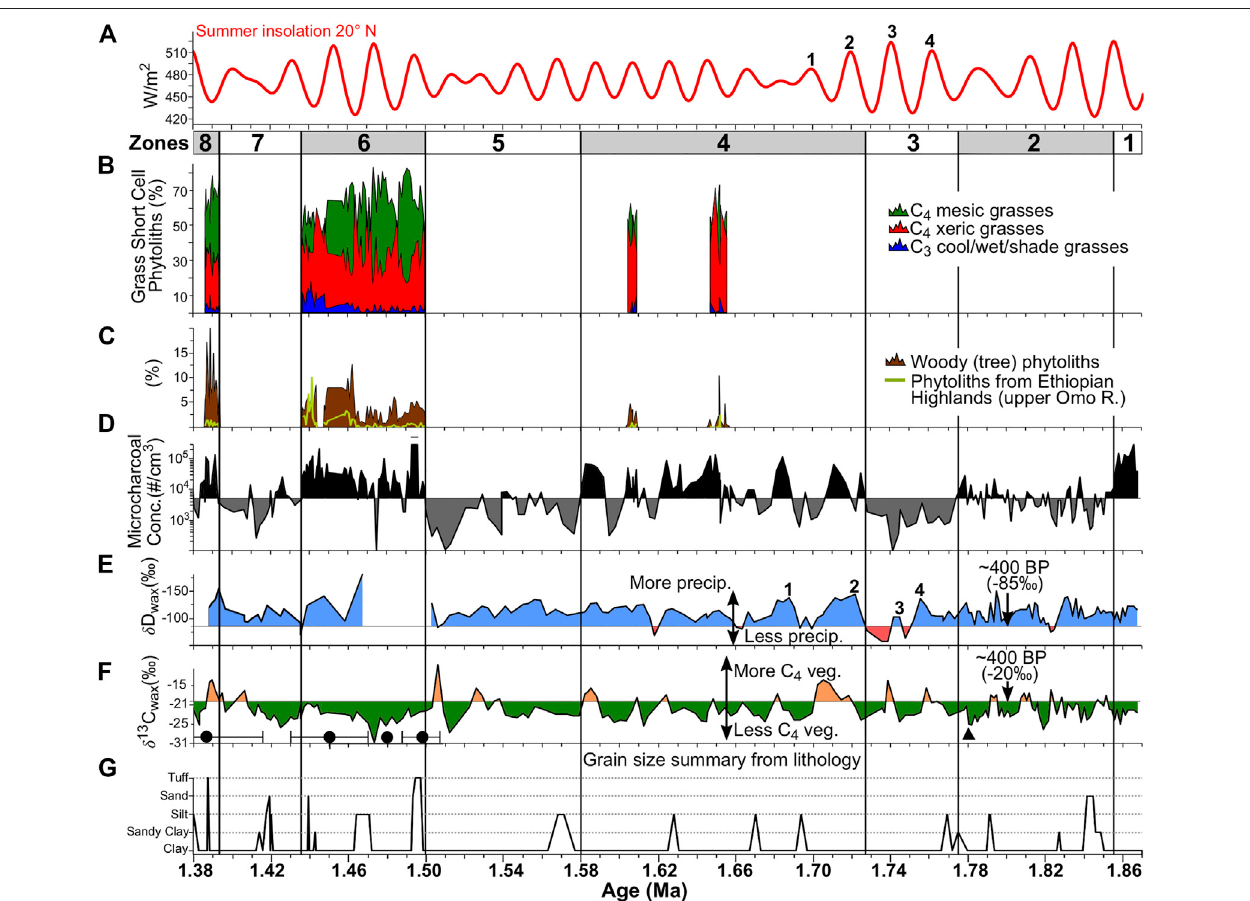
FIGURE 3 | Summary phytolith and microcharcoal datasets (this study) and leaf wax δ 13 C and δ D datasets (Lupien et al., 2018) from WTK13. (A) Summer 20 ° N insolation from Laskar et al. (2004). The numbered insolation peaks were tied to corresponding peaks in depleted δ D wax values depicted here in panel E by Lupien et al. (2018). (B) C 3 and C 4 grass relative abundance derived from grass short-cell phytoliths. (C) Tree/shrub phytoliths relative to total phytolith sum, and the I Omo index indicating relative abundance of phytoliths sourced from the Ethiopian Highlands ( Table 2 ). (D) Microcharcoal concentrations (log scale) with horizontal reference lineat5,000 cm − 3 tohighlightthezonalchanges. (E,F) δ D wax and δ 13C wax valuesfrom(Lupienetal.,2018),withhorizontalreferencelinessetatthelateHolocene δ D wax and δ 13 C wax values for Lake Turkana from Morrissey (2014). Black circles (tephrocorrelations and 40 Ar/ 39 Ar dating) and the black triangle (magnetic reversal) represent chronostratigraphic control points used in the age model. (G) Grain size summarized from the WTK lithological core description (see SOM Figure 2 ).